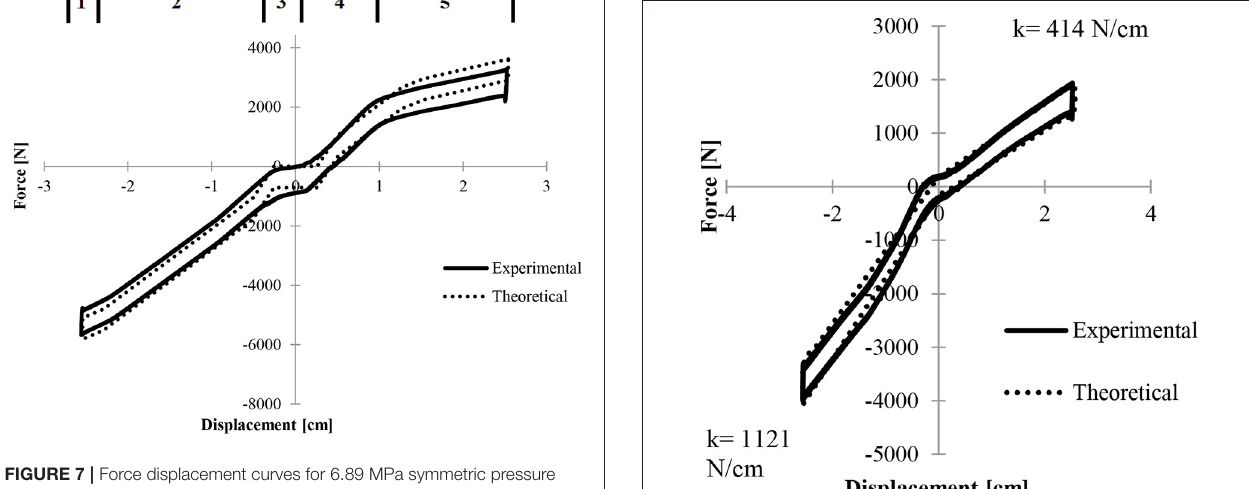
FIGURE 7 | Force displacement curves for 6.89 MPa symmetric pressure illustrating the zones of performance.